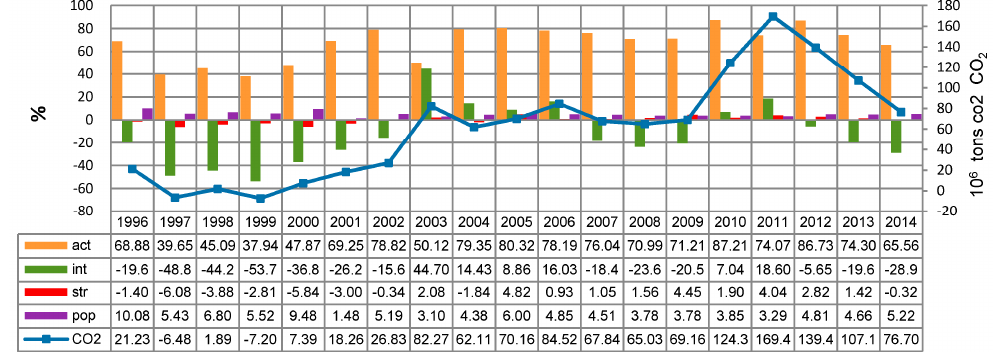
Figure 5. Decomposition of changes of CO 2 emissions in Northwest China.